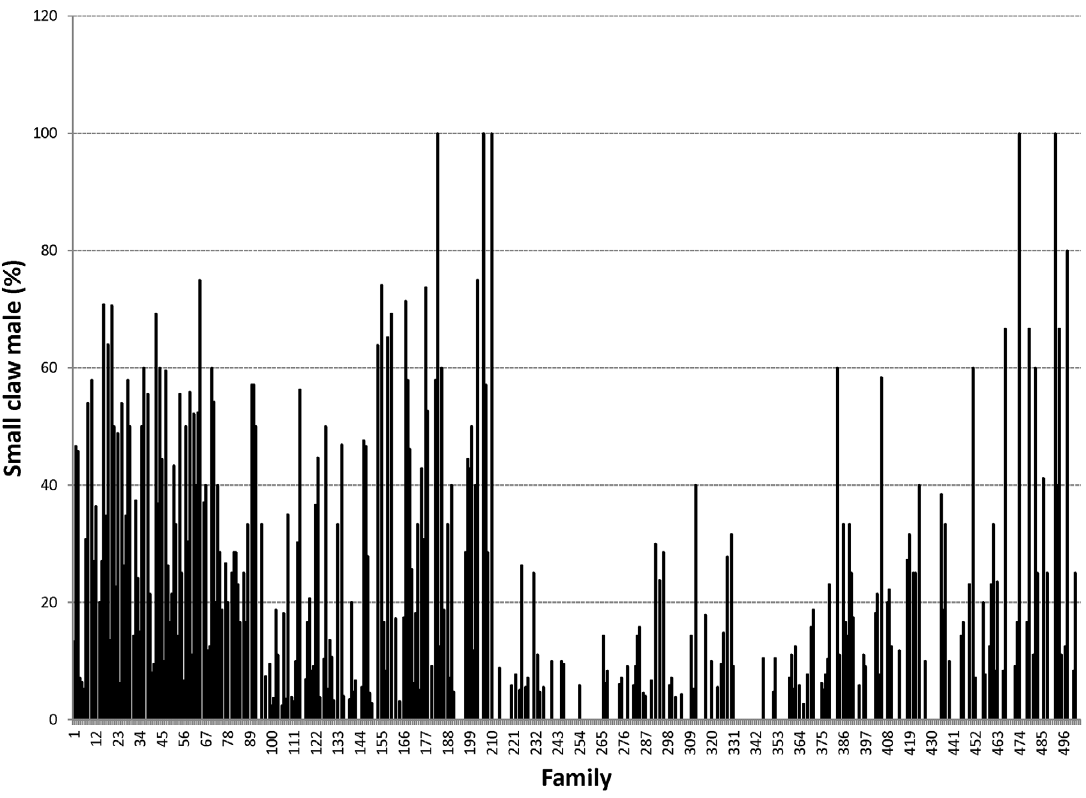
Figure 1. Small claw male morphotype.